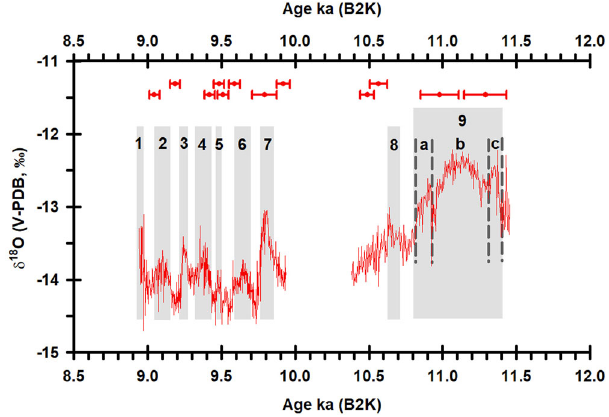
Fig. 2 High-frequency δ 18 O variations in stalagmite K4. Vertical shaded bars and numerals denote positive δ 18 O excursions identi fi ed in the KTC record. The broad excursion 9 is divided further into three substages. Each 230 Th date utilized in the age model is labeled by a red dot (mean age) with 2- σ